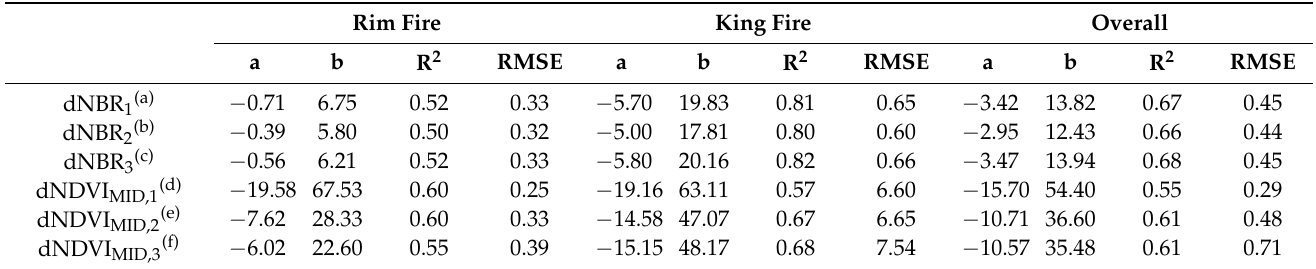
Table 4. Fitting parameters, coefficient of determination (R 2 ) and root mean square error (RMSE) of the saturated growth regression models between spectral indices as independent variables and the Geometrically structured Composite Burn Index (GeoCBI) as dependent variable. King